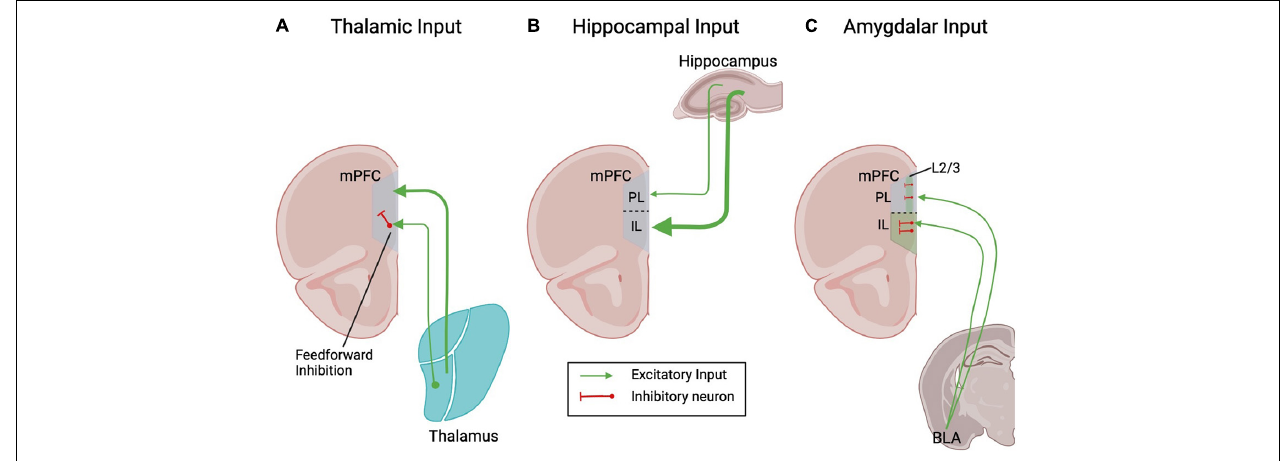
FIGURE 1 | Schematic depicting the main extracortical glutamatergic inputs to the rodent mPFC. Line thickness represents the connection strength.